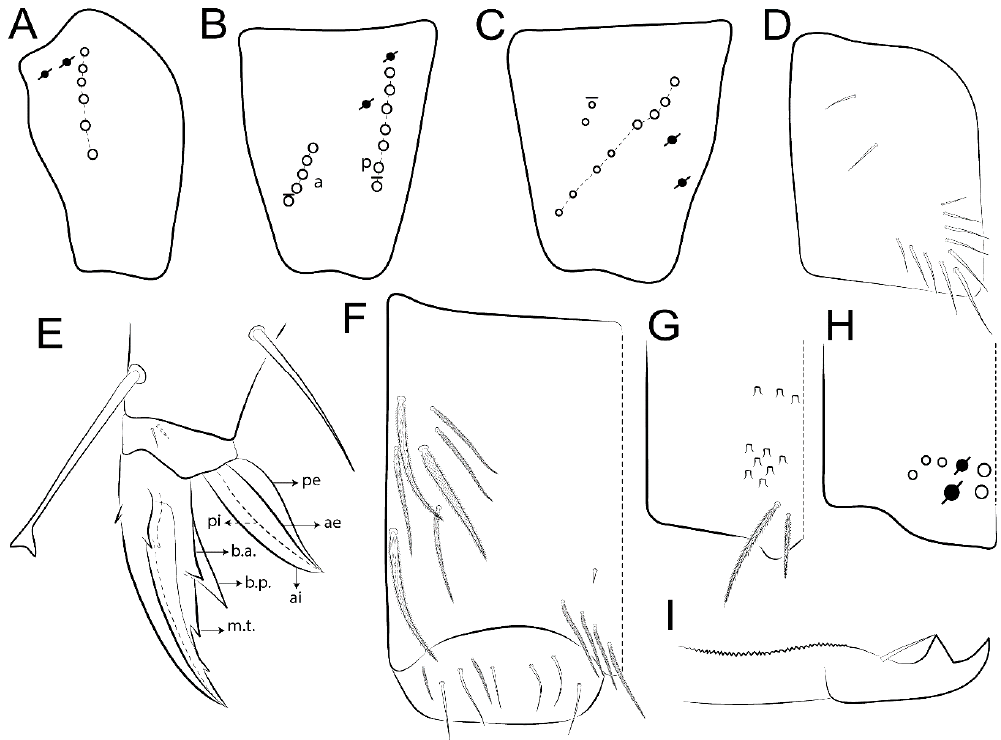
Figure 74. Pseudosinella parambigua sp. nov. ( A–C ) subcoxa I–III, respectively; ( D ) trochanteral organ; ( E ) distal tibiotarsus and empodial complex III (anterior view); ( F ) collophore (lateral view); ( G ) distal part of manubrium (ventral view); ( H ) manubrial plate (dorsal view); ( I ) distal dens and mucro (outer view).